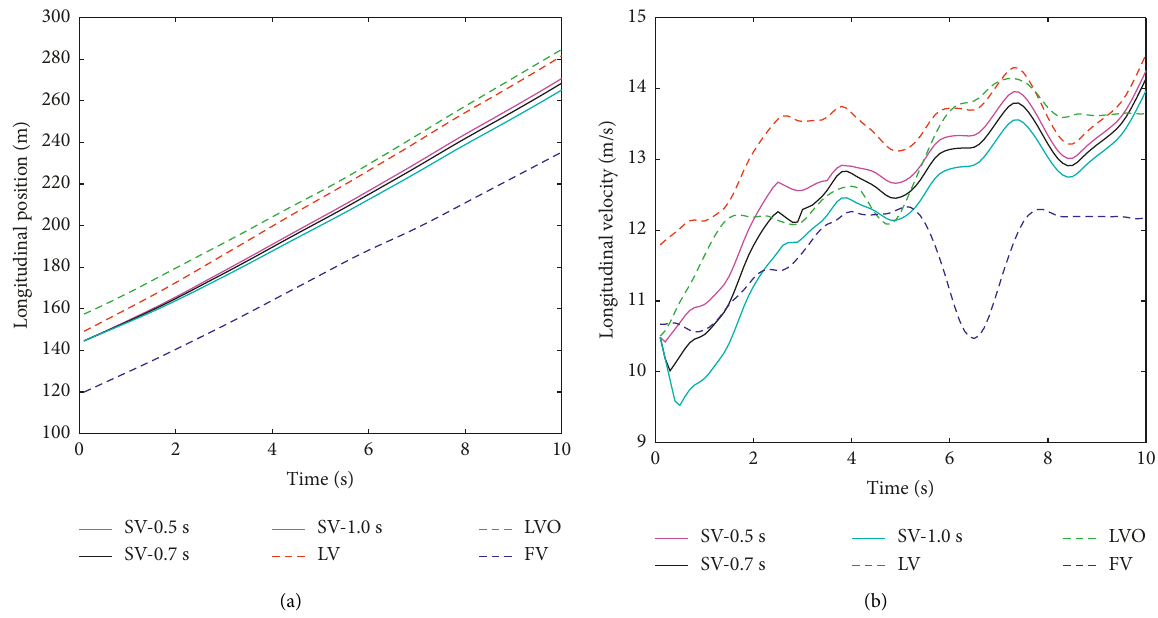
Figure 14: Results for different reaction times. (a) Plot of longitudinal position with respect to time. (b) Plot of longitudinal velocity with respect to time.